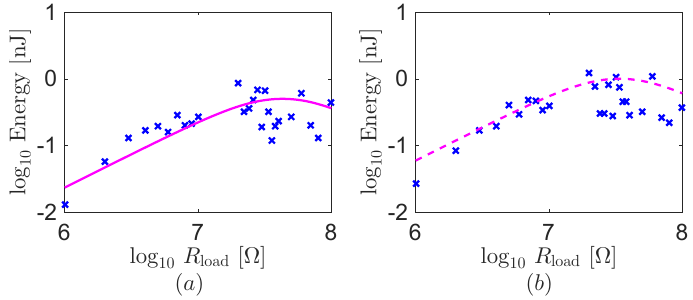
Figure 11. Theoretical predictions and experimental results on energy transferred to the load resistance as a function of the resistance using the human index finger. ( a ) One click and ( b ) double click. Blue crosses and purple lines are the experimental results and the theoretical predictions,